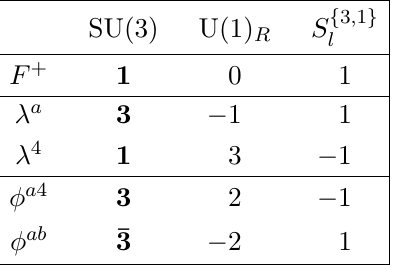
Table 3 . The charges carried by the component (cid:12)elds of the N = 4 super Yang-Mills multiplet under the S f 3 ; 1 g S-fold operator (in units of 2 (cid:25)=k ) and the invariant SU(3) (cid:2) U(1) R (cid:26) SU(4) b R-symmetry